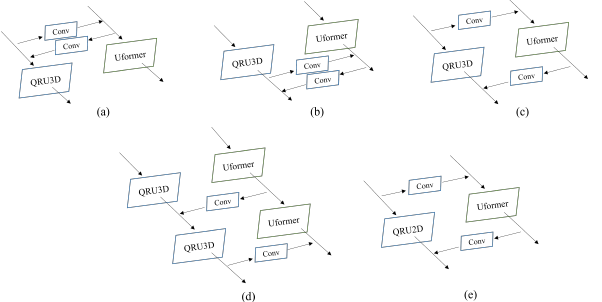
Figure 11. Visualization of different network structures. Case ( a ) and case ( b ) place the BI bridge in the input and the output of the unit, respectively, and case ( c ) places one way of the bridge in the input and the other way in the output. In addition, there is only one direction of information exchange in case ( d ) and case ( e ) replaces 3D convolution with 2D convolution in each TRQ3D